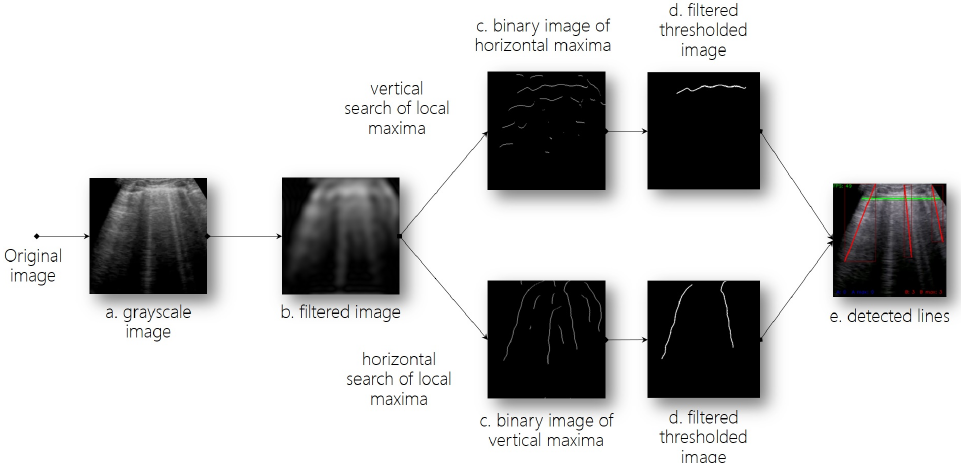
Figure 3. Line detection process. ( a , b ). Preprocessing; ( c ). Detection of candidate lines; ( d ). Line filtering; ( e ). Line